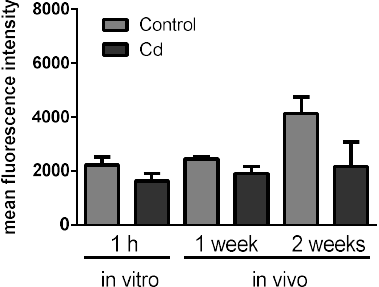
Figure 2. Flow cytometry of coelomocytes derived from Cd-exposed (50 mg / kg dry soil) and control earthworms stained with LysoTracker ® Green to determine lysosome numbers. In vitro exposures were accomplished using 200 µM CdCl2. t -tests did not indicate any significant differences.